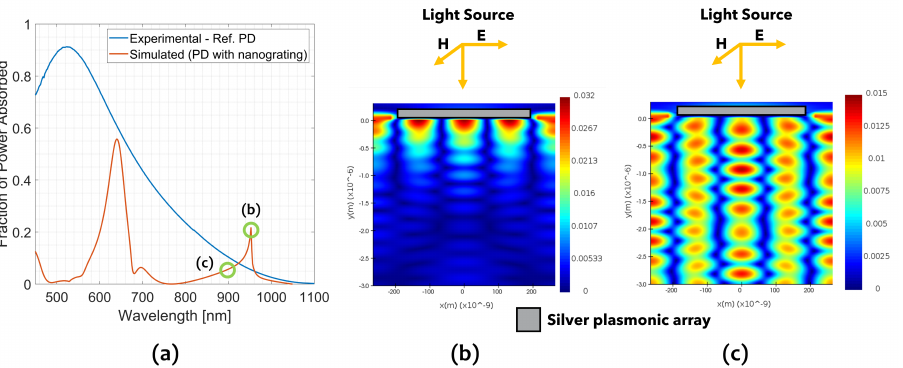
Figure 3. ( a ) Simulated absorbed light (orange solid line) and reference spectra (blue solid line) as a function of wavelength in the range (450–1100) nm; ( b ) magnetic field intensity profile of the simulated section in Figure 2 at 950nm; and ( c ) magnetic field intensity profile of the simulated section in Figure 2 at 880nm demonstrating a diffraction pattern.